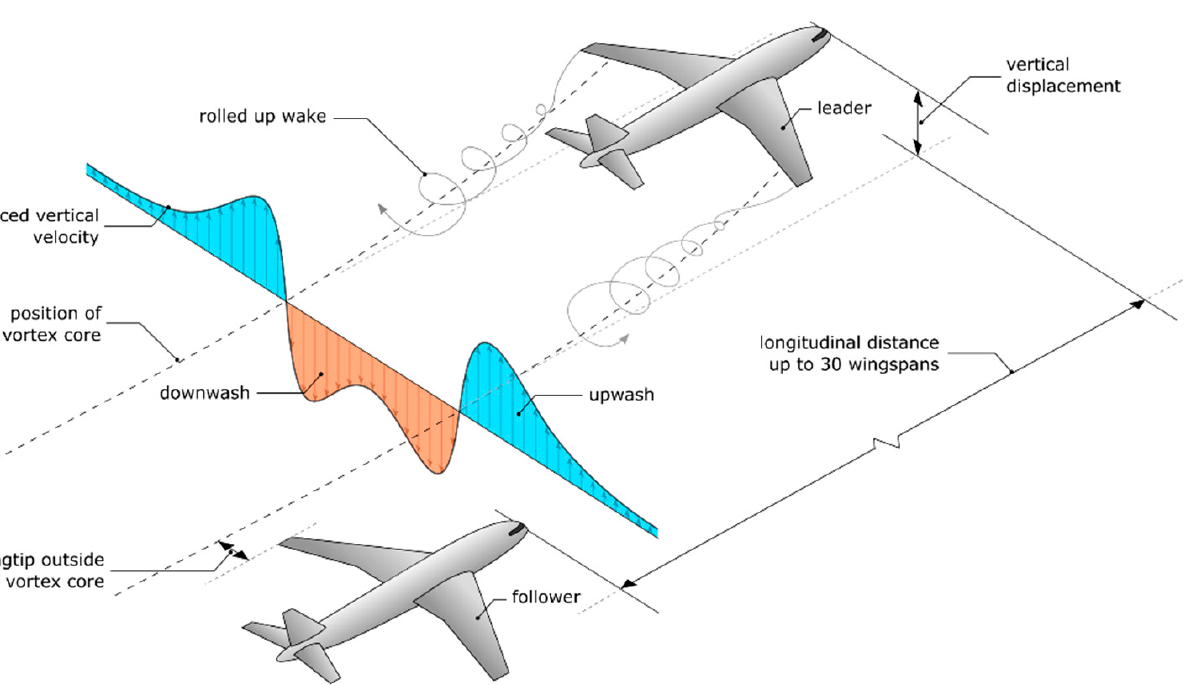
Figure 1. Migratory birds flying in a typical V-shaped formation (photography by Tobias Marks).